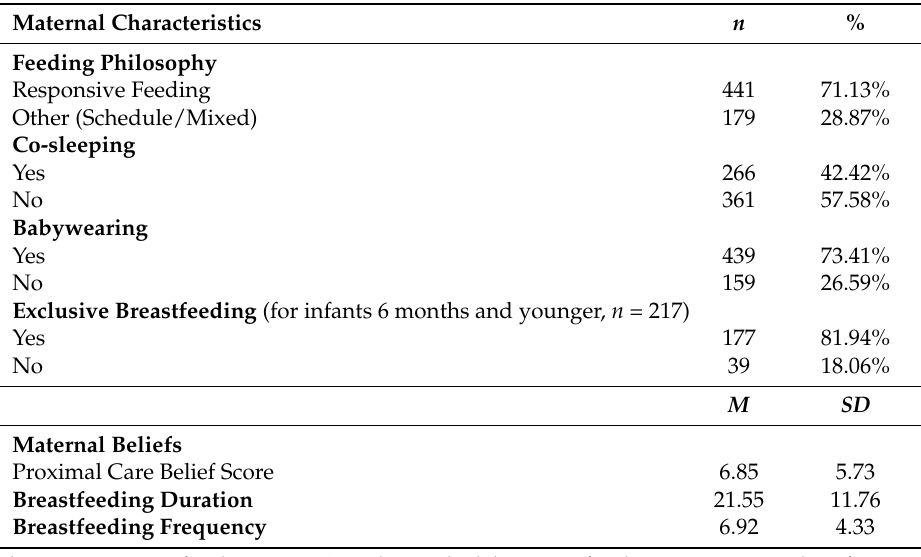
Table 2. Descriptive statistics for the participants in Study